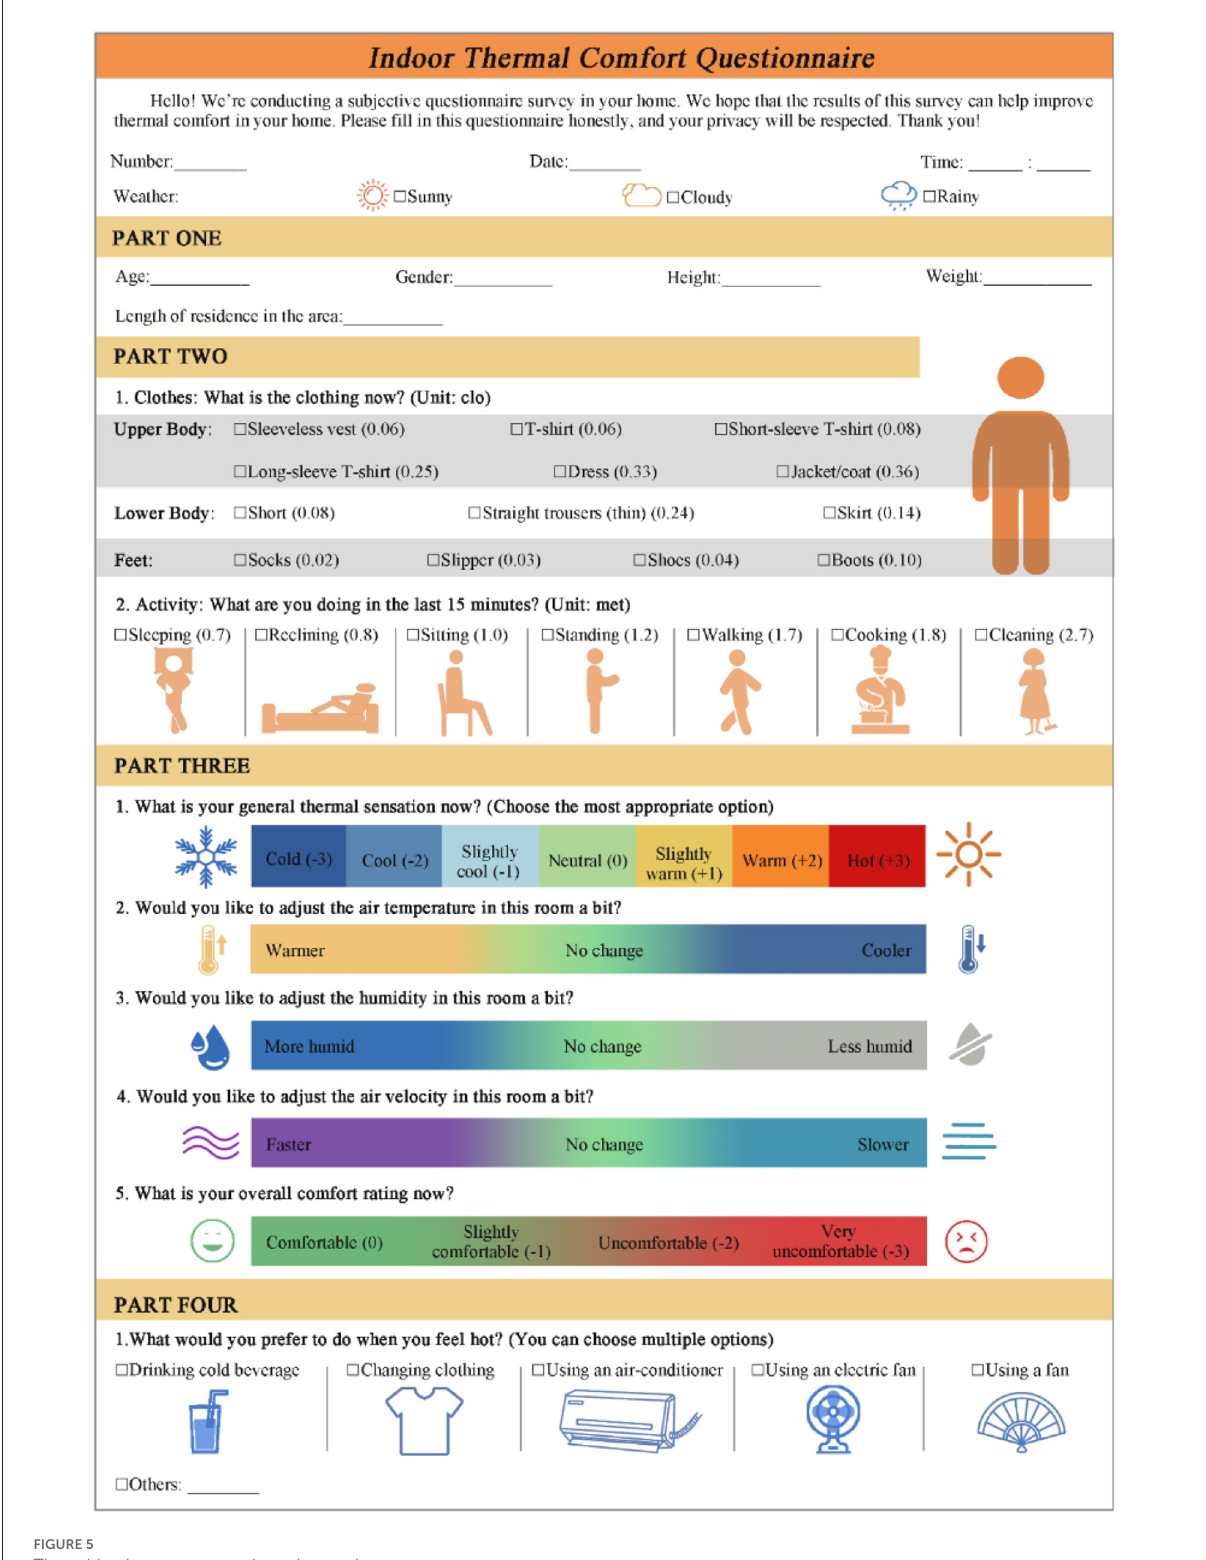
FIGURE5 The subjective survey questionnaire